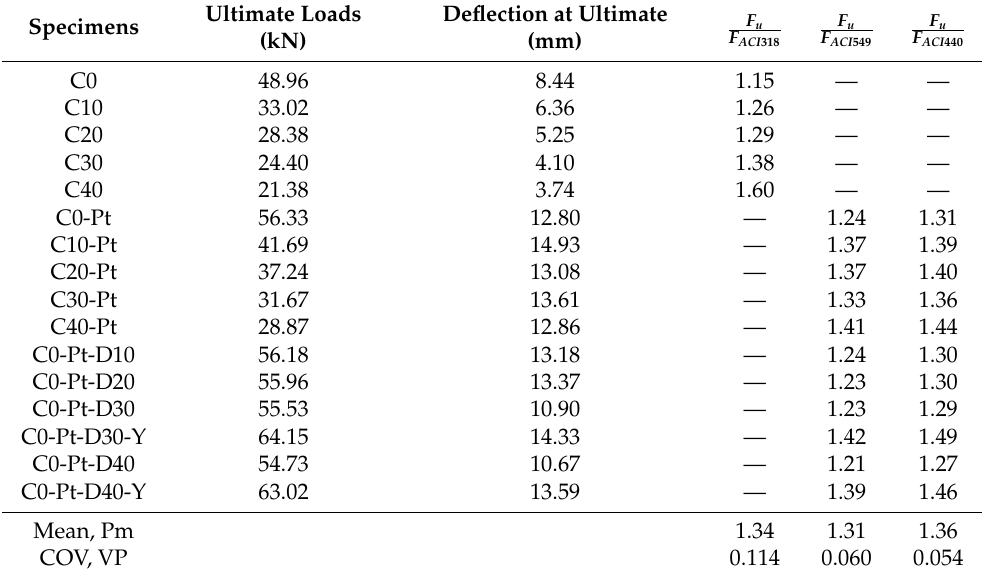
Table 5. Ultimate loads and corresponding deflection obtained from FE